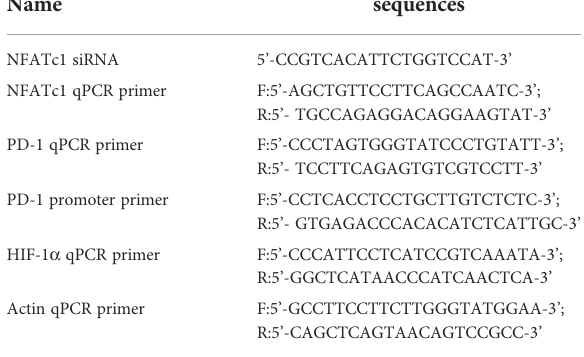
TABLE 1 siRNA and primer sequences